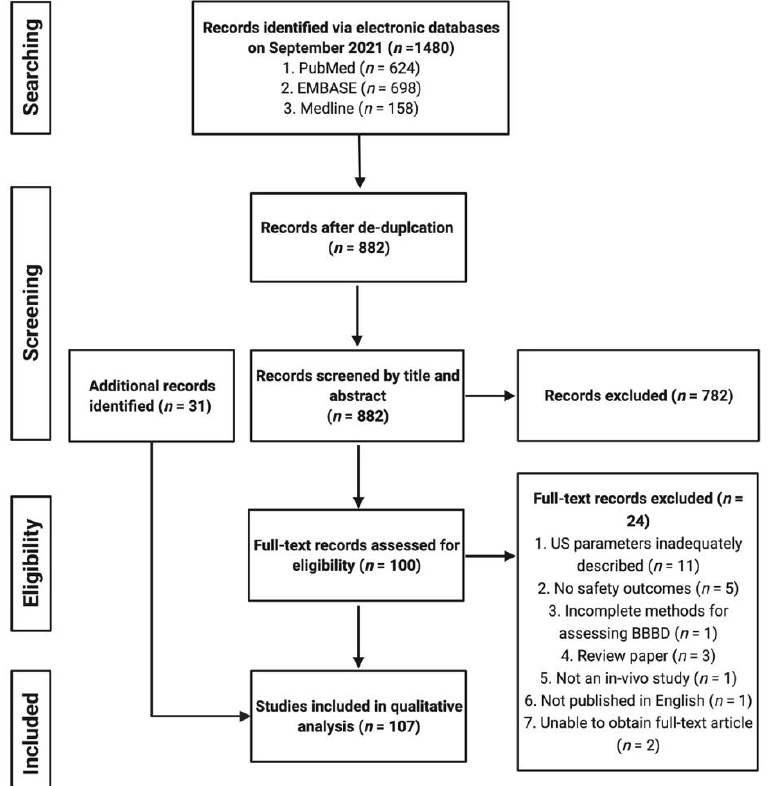
Figure 2. Flowchart highlighting the screening and selection process for studies included within this systematic review. ( Created with Biorender.com (accessed on 12 March